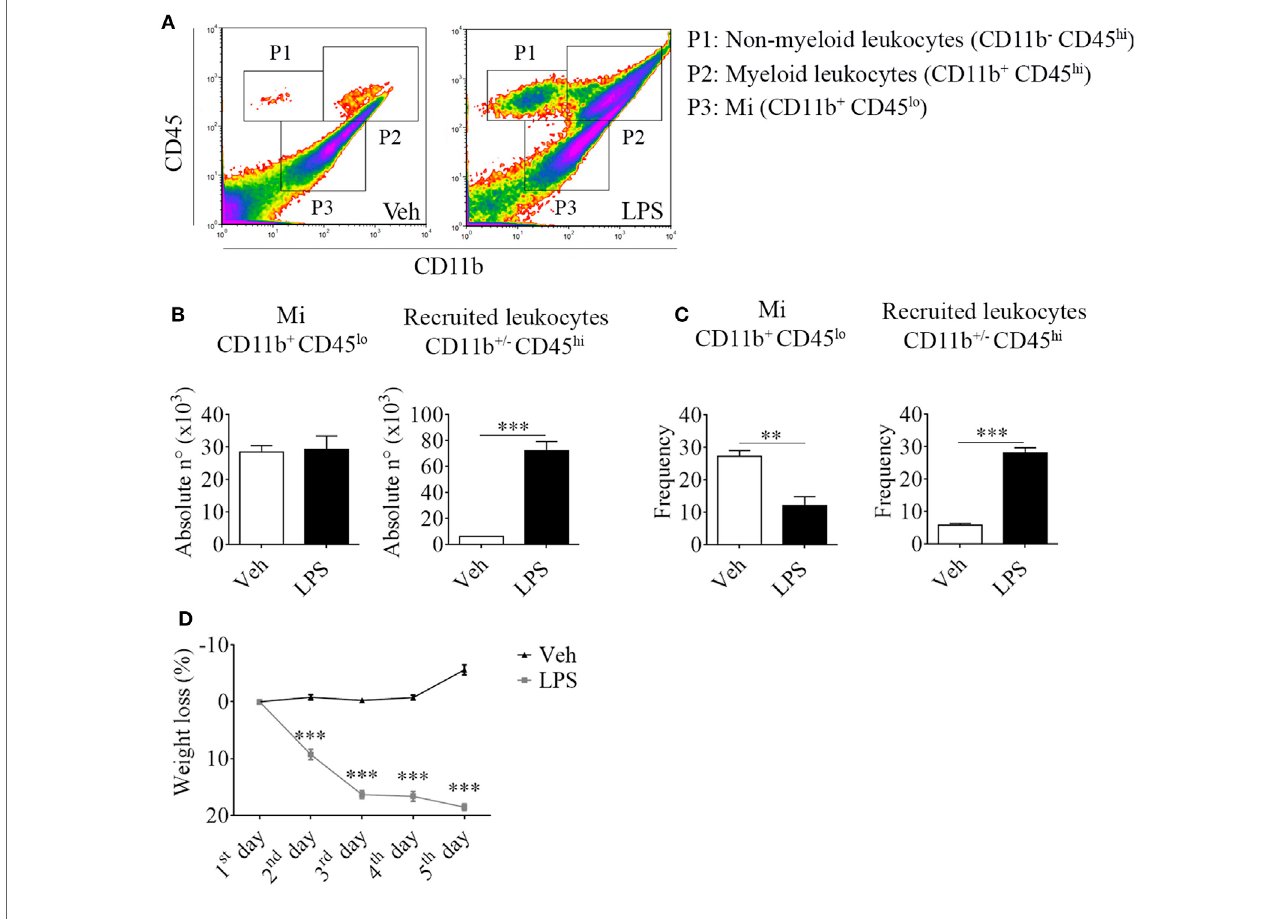
FigUre 1 | Lipopolysaccharide (LPS) stimulation induces the recruitment of peripheral CD11b + / − CD45 hi cells to the central nervous system. Mice were treated i.p. with either vehicle or 40 µg of LPS (1,6 mg/kg) for four consecutive days to induce neuroinflammation. Twelve hours post the last injection, mice were euthanized and immune cells were isolated from whole brain homogenates and labeled for subsequent flow cytometric analysis. (a) Representative CD45 vs CD11b flow cytometry density-plots illustrating the gating analysis strategy employed. P1: CD11b − CD45 hi lymphoid recruited leukocytes; P2: CD11b + CD45 hi myeloid recruited leukocytes; P3: CD11b + CD45 lo microglial cells. (B) Absolute number and (c) frequency of CD11b + CD45 lo microglial cells, CD11b + / − CD45 hi recruited leukocytes, CD11b + CD45 hi Ly6C + Ly6G + neutrophils, and CD11b + CD45 hi Ly6C hi Ly6G − inflammatory monocytes, were assessed by flow cytometry. The percentage of these two last populations corresponding when gated in CD11b + CD45 hi . Results are representative of at least three independent experiments ( n = 3–4 animals per group). (D) Mice weight loss following the i.p. administration scheme with vehicle or 40 µg of LPS (1.6 mg/kg) for four consecutive days to induce neuroinflammation. Results are representative of at least three independent experiments ( n = 3–20 animals per group). Data are expressed as mean ± SEM. Mi, microglial cells; PMN, neutrophils; Inf Mo, inflammatory